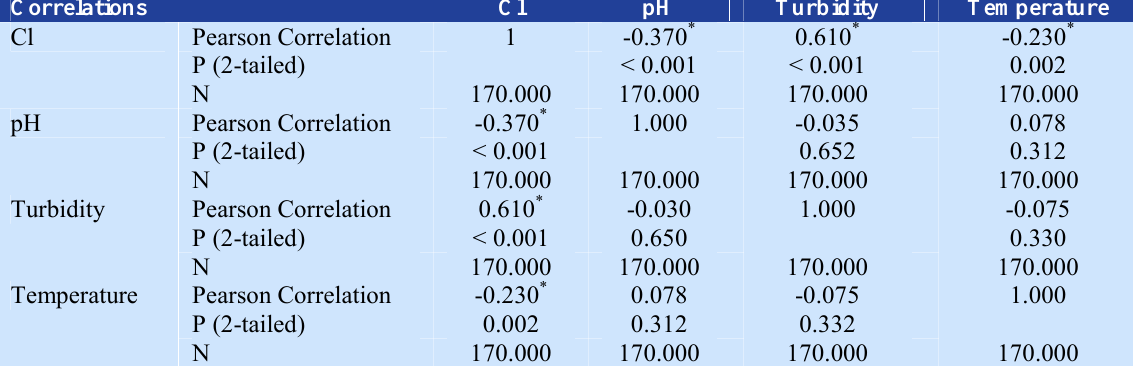
Table 2. The results of paired samples statistics for winter and spring